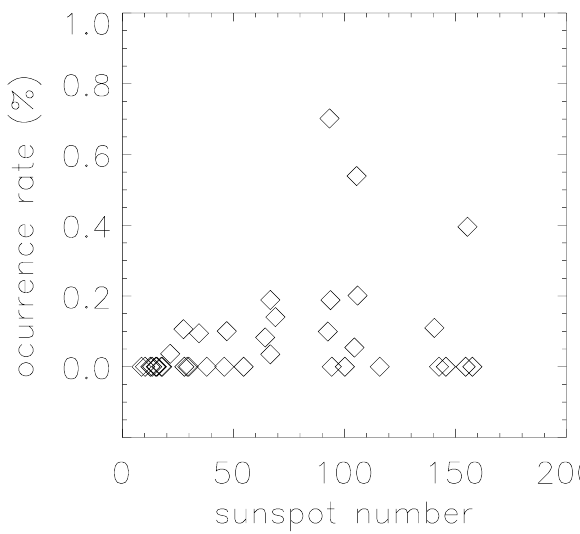
Fig. 4. A scatter plot of yearly sunspot numbers and annual occur- rence rates of low-density solar wind (density 0.5 cm − 3 or